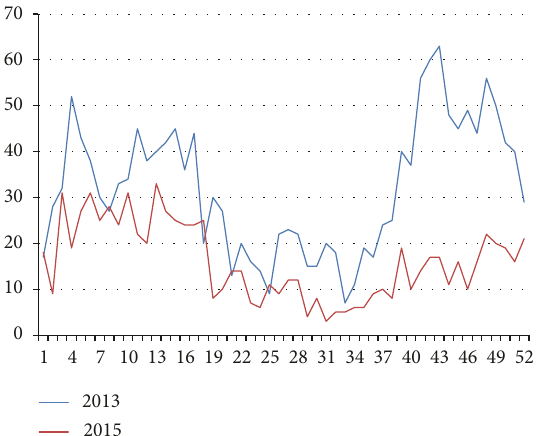
Figure 5: Intra-annual (week by week) dynamics of pneumonia morbidity of children’s population of the Amur Region (epidemiological monitoring, absolute values).